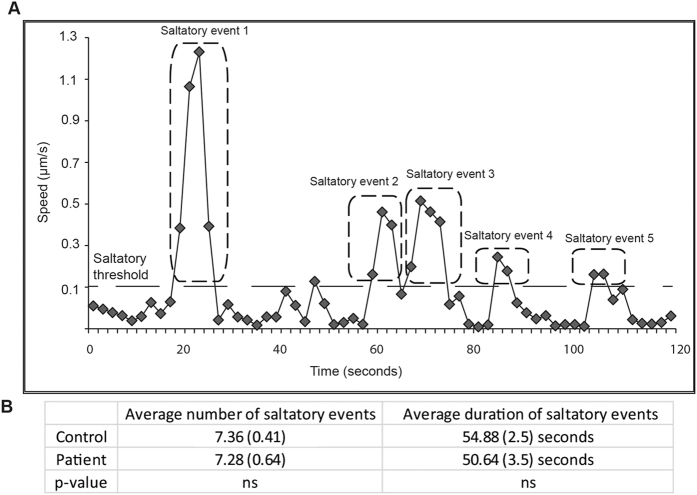
Time-dependent dynamics of peroxisome movement.(A) Example of saltatory movements of a single peroxisome from a patient axon-like process, with speed plotted against time. Saltatory events were defined as those exceeding a threshold (dashed line at 0.1 μm/s). Five saltatory events are indicated. (B) Saltatory events were quantified from approximately 200 fast moving peroxisomes from patient and control axon-like processes. Data are represented as Mean ± SEM. Fast moving peroxisomes were defined as those exceeding the average speed of the fastest 10% of control peroxisomes (1.4 μm/s).